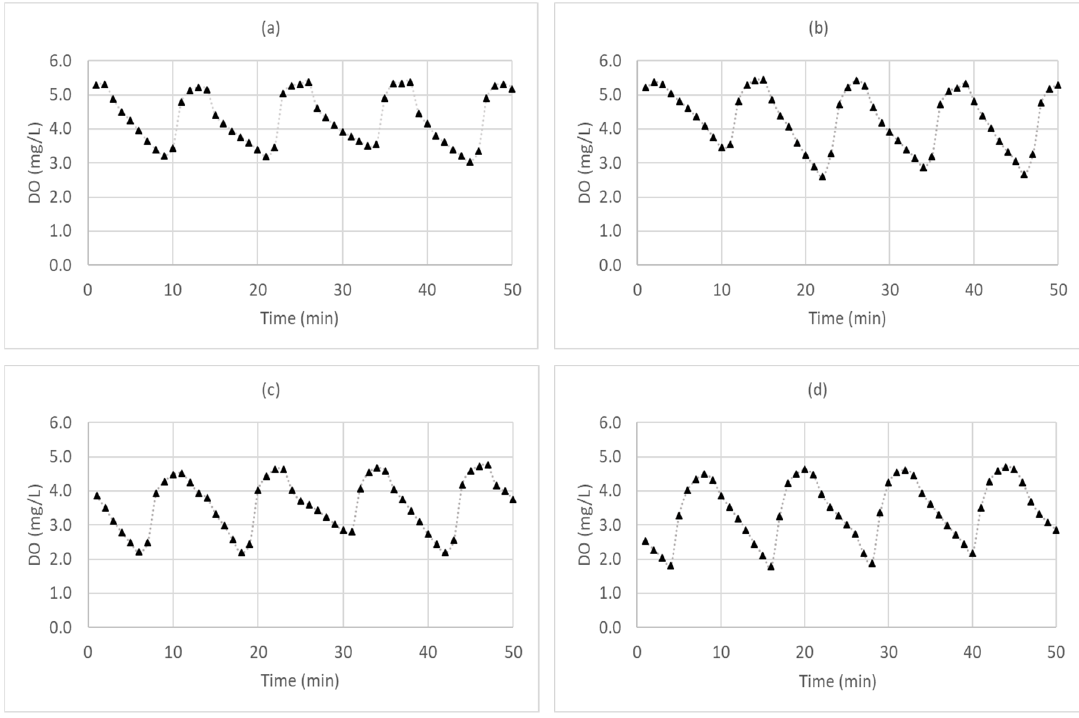
Figure 6. DO concentration variation in the HyVAB for Trial 2: ( a ) DO profile on the 262nd day, ( b ) DO profile on the 264th day, ( c ) DO profile on the 292nd day, and ( d ) DO profile on the 295th day.